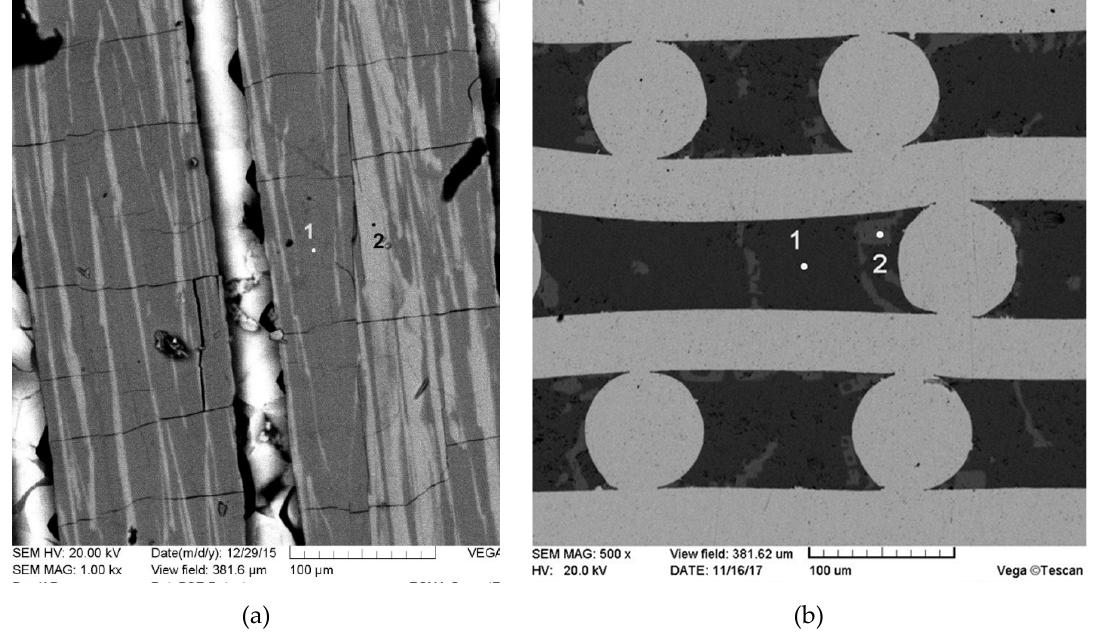
Figure 4. SEM micrographs of the longitudinal ( a ) and transverse ( b ) sections of the composite specimen. The raw material was sintered at 1250 °C and the fiber crystallization rate was 2 mm/min.